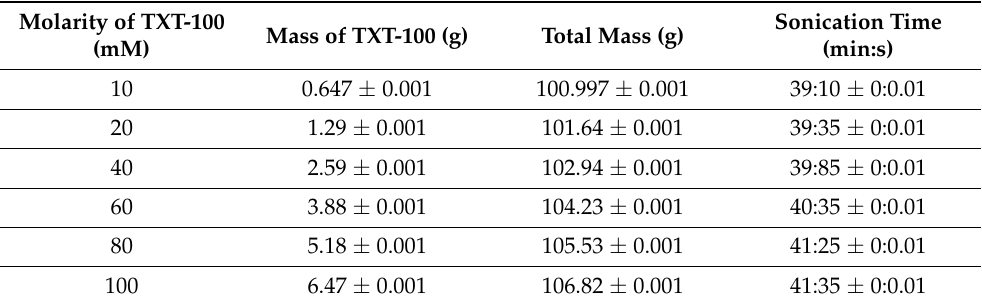
Table 1. Mass of TXT-100, total mass of the mixture, and sonication time for each molarity of TXT-100, following the parameters: energy—390 J/g and 0.35% mass MWCNT of the